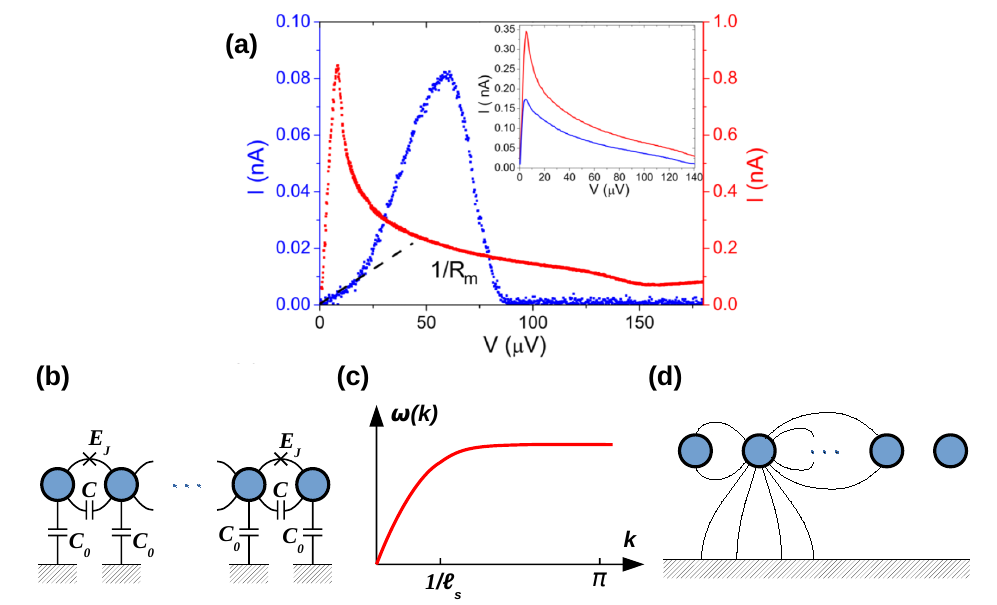
Figure 7: (a) Current-voltage characteristics of a small Josephson junction connected to a Josephson junction chain at two different values of the magnetic field. The inset shows the corresponding I − V curve for the uniform chain [ 95 ] . (b) Schematic representation of a Josephson junction chain. Josephson and capacitive electro- static coupling between neighboring superconducting islands are represented by the crosses and the capacitors C , respectively. The self-capacitance of the islands is rep- resented by the capacitors C between the islands and the ground. (c) Schematic 0 plot of the frequency dispersion for phase excitations of a Josephson junction chain. (d) Schematic representation of the long-range Coulomb coupling between the chain islands and its screening by a remote ground plane (the thin curves represent electric field